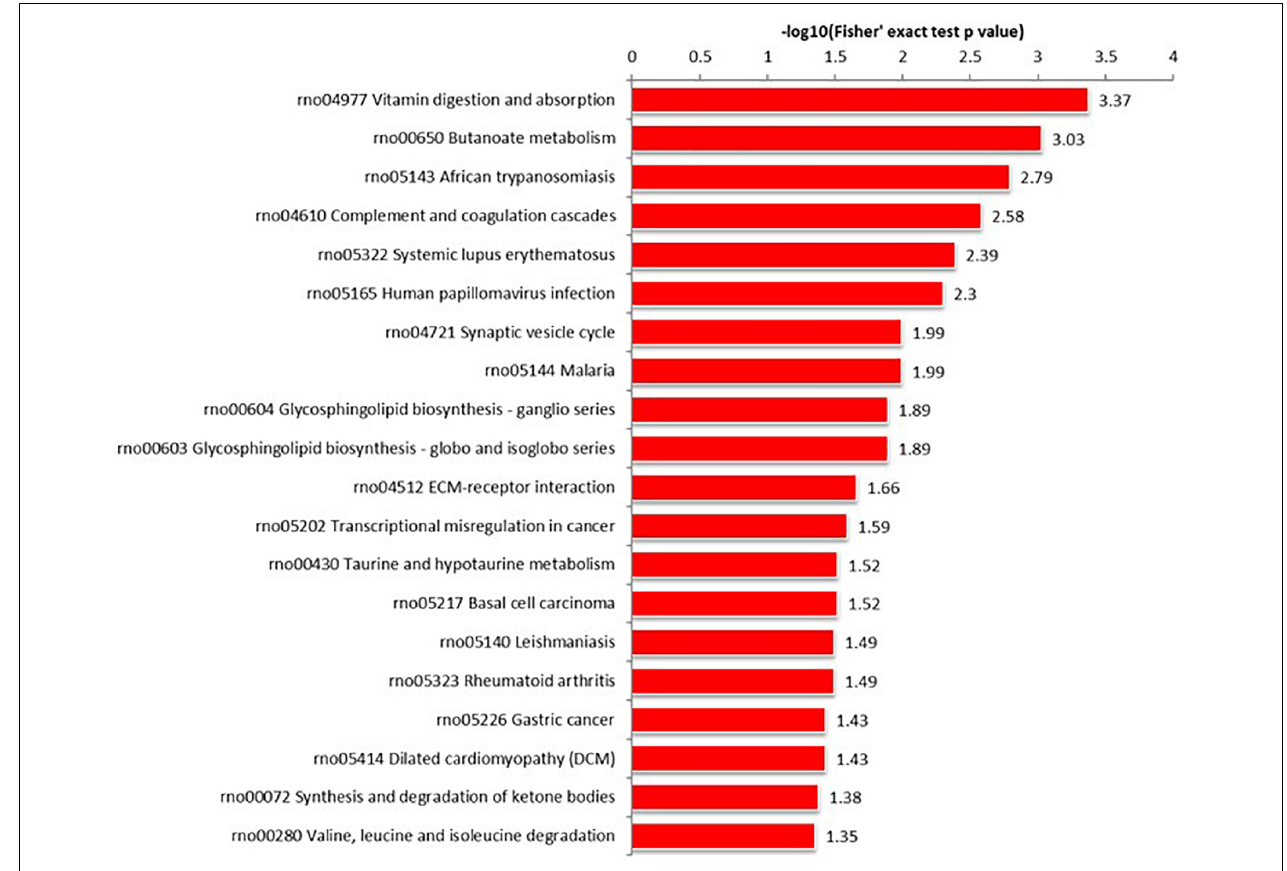
FIGURE 5 | KEGG pathway enrichment analysis of proteins differing in abundance between SE + KD and SE groups. Vitamin digestion and absorption pathway showed highest enrichment. Differentially abundant proteins were also enriched in ‘synaptic vesicle